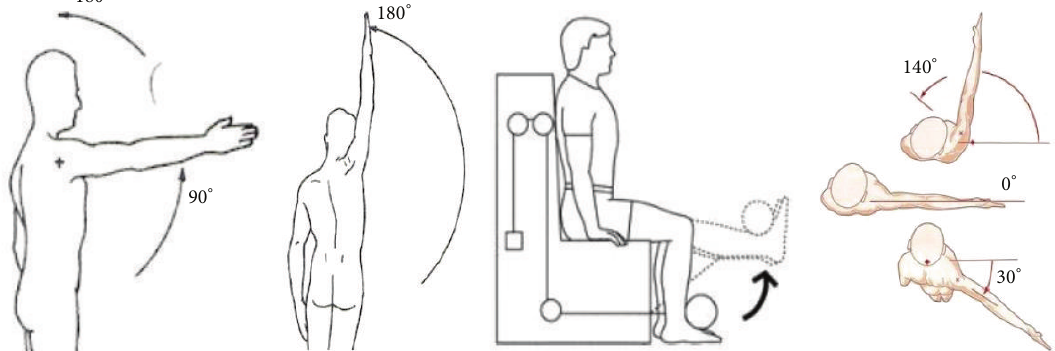
Figure 6: Exercises performed using eFisioTrack whose results are included in this work. From left to right: free active shoulder flexion, free active shoulder abduction, leg extension, and free horizontal shoulder